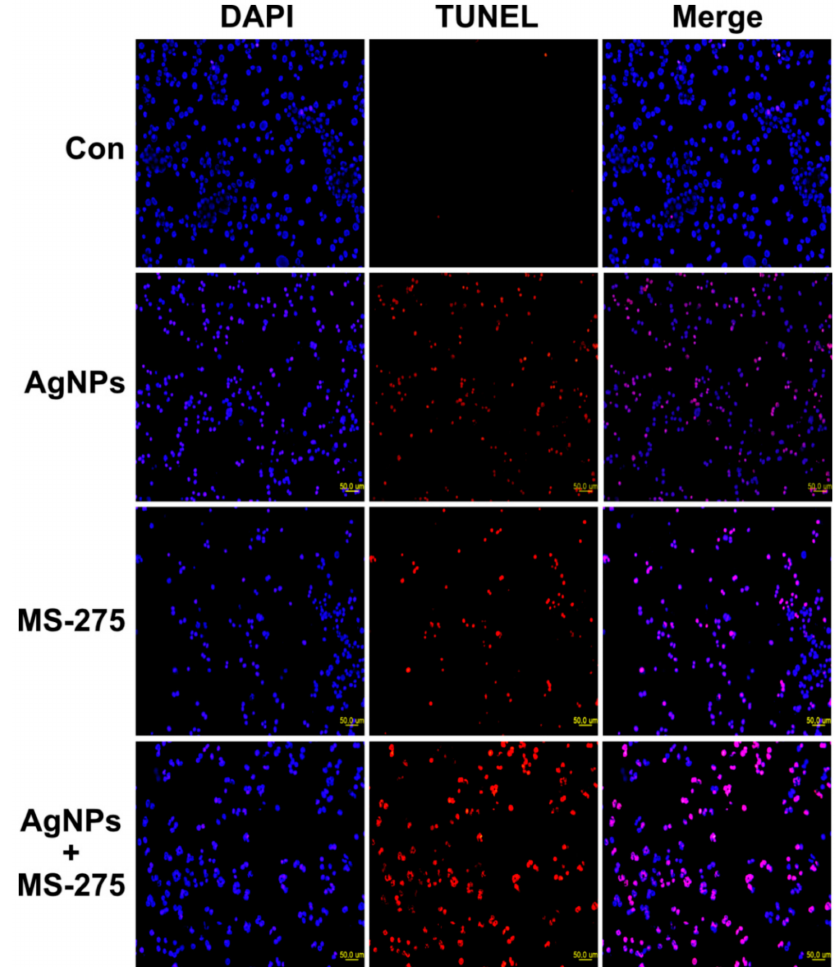
Figure 11. Analysis of apoptosis of A549 cells. A549 cells were incubated with AgNPs (1 µ M), MS-275 (1 µ M), or a combination of AgNPs (1 µ M) and MS-275 (1 µ M) for 24 h. After 24 h treatment, apoptosis was assessed by the transferase-mediated dUTP nick end labelling (TUNEL) assay; the nuclei were counterstained with DAPI. Representative images show apoptotic (fragmented) DNA (red staining) and the corresponding cell nuclei (blue staining). The images are × 50 µ m